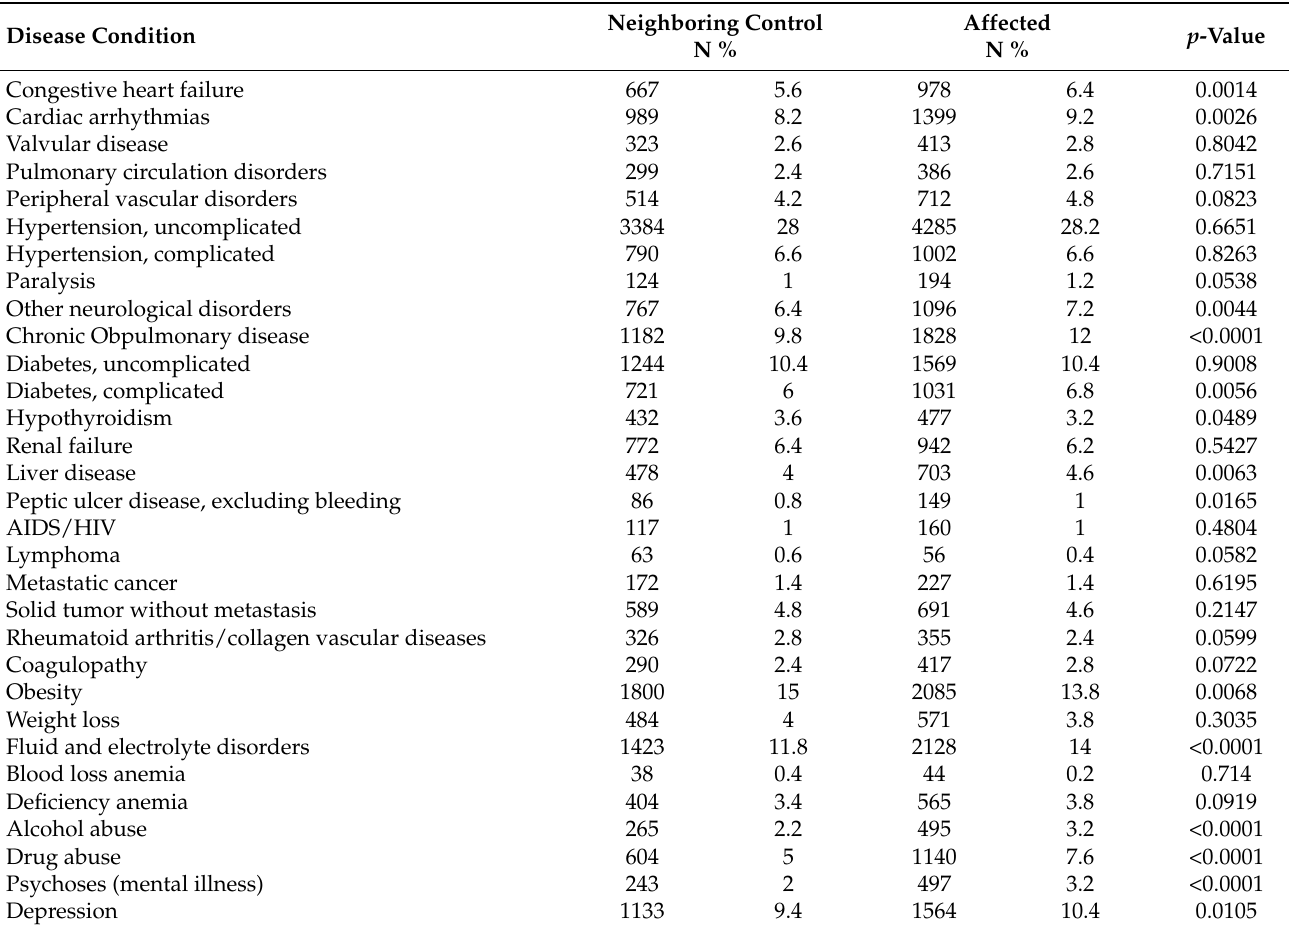
Table 4. Prevalence of Elixhauser comorbidity conditions stratified by